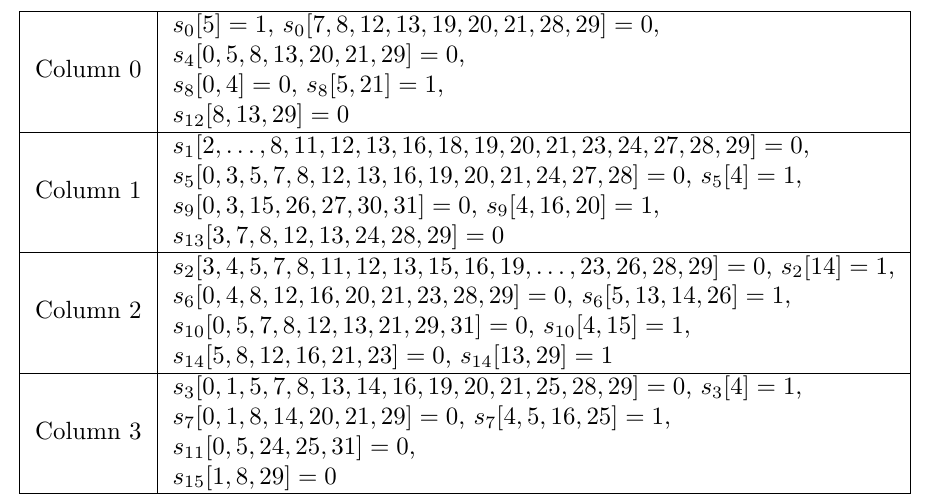
Table 10: Conditions on the initial state for